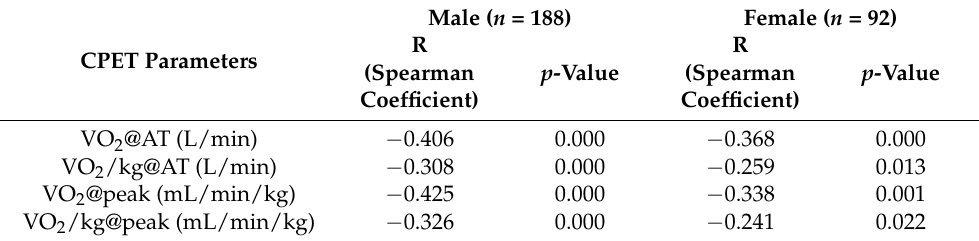
Table 4. Correlation analyses between CPET parameters and Gensini